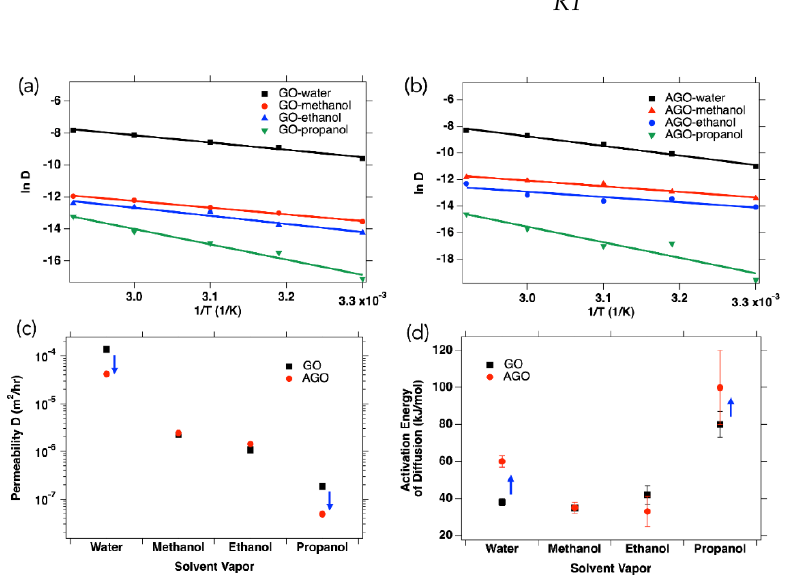
Figure 5. Arrhenius plots for ( a ) GO permeability and ( b ) AGO permeability to water, methanol, ethanol, and propanol. The lines in ( a , b ) are fit to Equation (4). ( c ) Permeability of GO and AGO membranes to different polar solvents at 30 °C. ( d ) Activation energies of diffusion for water, methanol, ethanol, and propanol through the GO and AGO membranes.